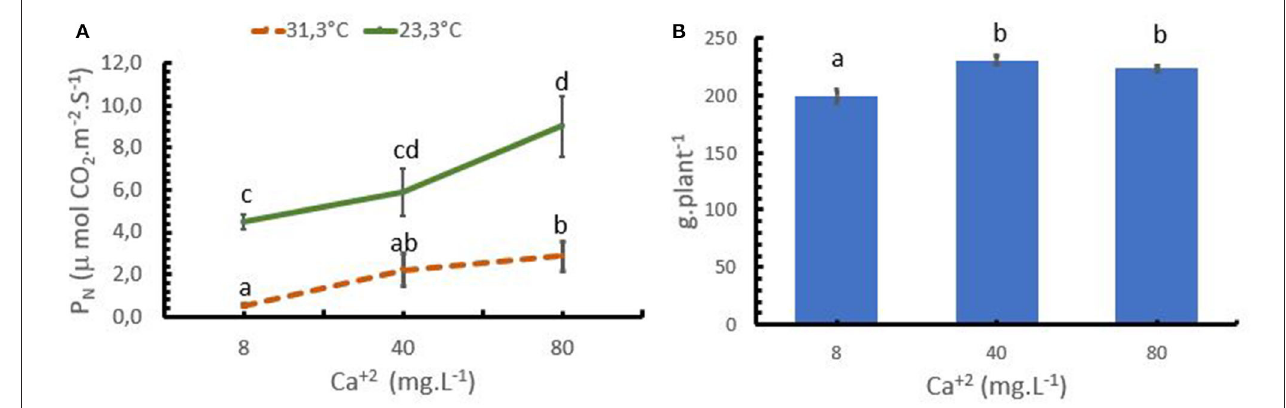
FIGURE 4 | Effect of the calcium (Ca + 2 ) on the photosynthesis (P N ) of coffee plants at 2 temperature levels ( A) , and in biomass accumulation (B) . Points and bars represent the mean values for each of the replicates ± standard error. Different letters represent statistically significant differences among the treatments ( P < 0.05, LSD